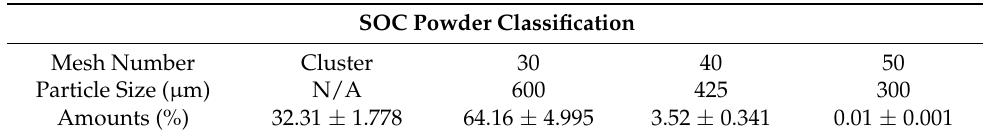
Table 1. Sesame oil cake (SOC) powder particle size distribution.